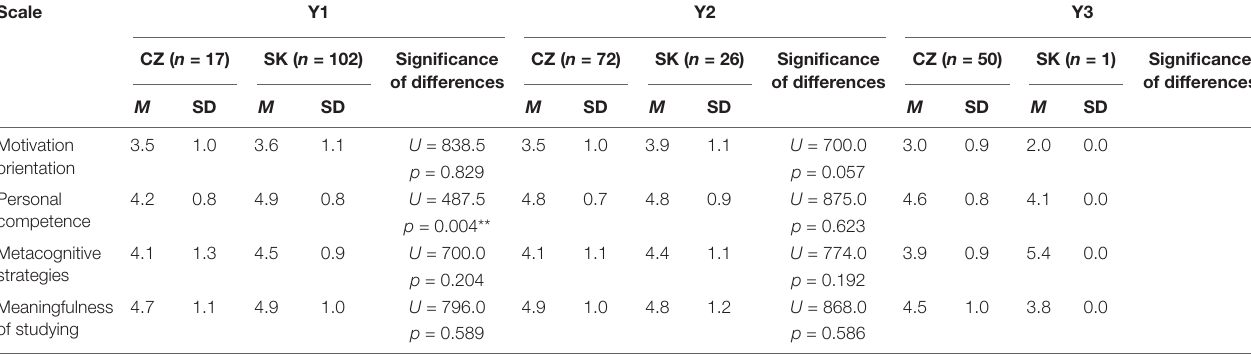
TABLE 6 | An overview of the analysis by year of